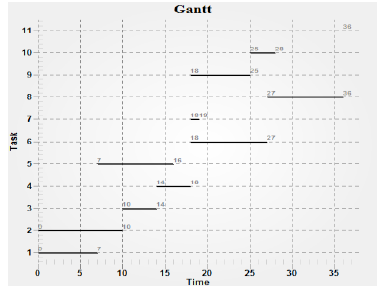
Fig.5 Schedule of Project 2(OS=0.3 RC=0.7)